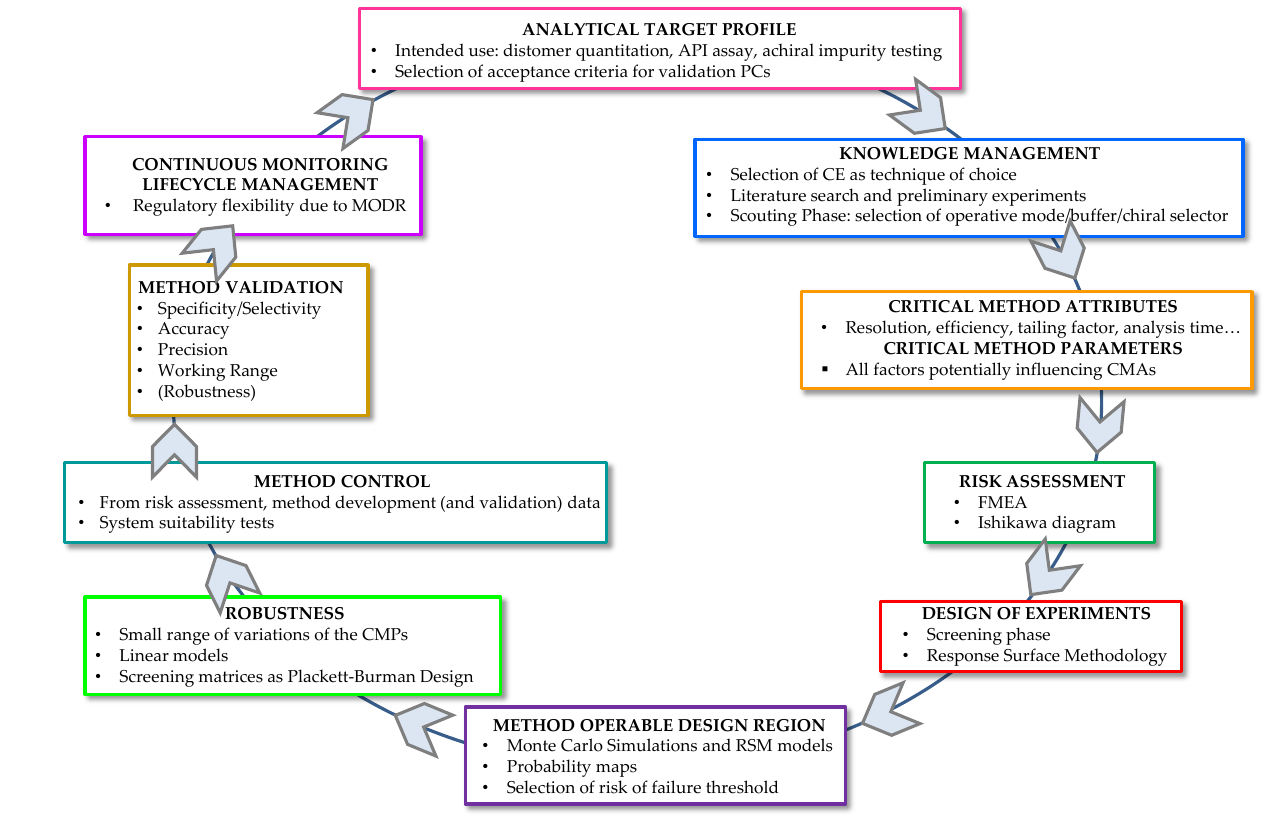
Figure 4. Analytical Quality by Design in CE.